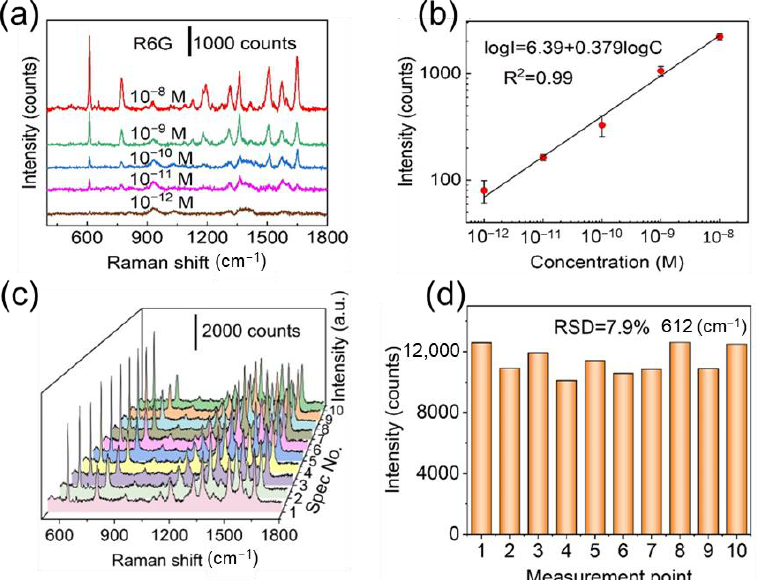
Figure 2. ( a ) Raman signal of R6G with concentrations from 10 −8 M to 10 −12 M. ( b ) A linear relationship between the logarithmic concentrations and logarithmic intensities at 612 cm −1 . ( c ) SERS spectra of 10 −7 M R6G gathered from 10 different points on the fabricated Ag/ZnO NR arrays. ( d ) Distribution of relative signal intensities at 612 cm −1 peak. Spectral uniformity and reproducibility are other vital indicators for the practical ap- plication of a SERS substrate. As shown in Figure 2c, a series of SERS spectra of 10 −7 M R6G randomly collected from 10 different measuring points on Ag/ZnO NR arrays were highly consistent. The relative standard deviation (RSD) of the signal intensity variations